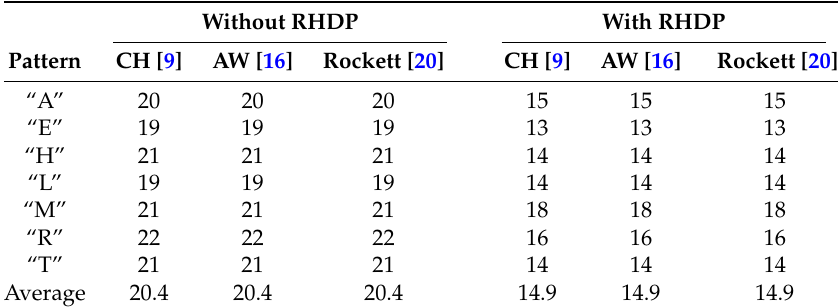
Table 2. NI measurements for the results given in Figure 14 by applying the presented approach with three fully-parallel thinning algorithms. The average NI with the RHDP process is 27% less than that without the RHDP process. Without RHDP With RHDP